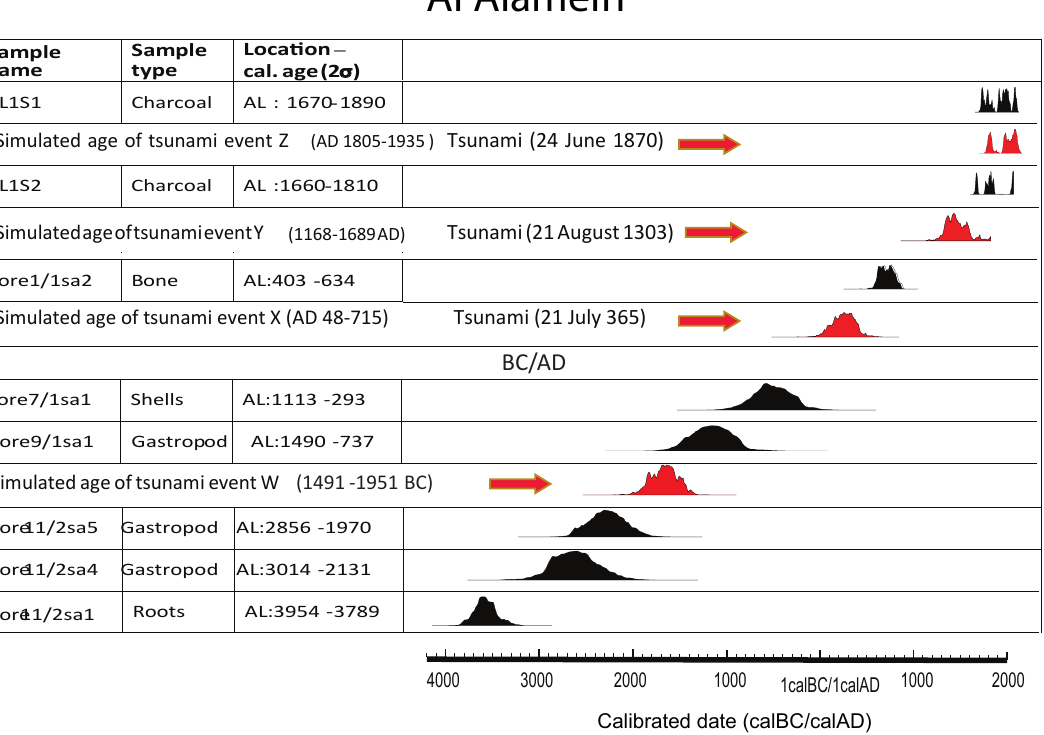
Figure 6. Radiocarbon dating calibrated with probability density function (pdf) using Oxcal version 4.2 (Bronk-Ramsey, 2009) and chronol- ogy of sedimentary layers with dated tsunami records at El Alamein. The dating characteristics are in Table 2b. Black pdfs refer to the dated samples and red pdfs are simulated dating of the four tsunami records. Three sedimentary records are correlated with the historical earthquake and tsunami catalogue of the eastern Mediterranean (see Table